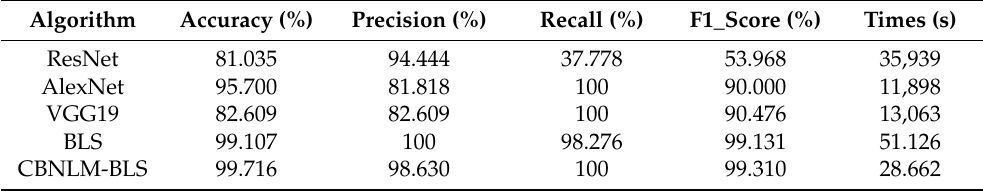
Table 2. Explanatory table for evaluation indicators. Table 3. Comparison of the classification results in different classification algorithms for wind turbine blade